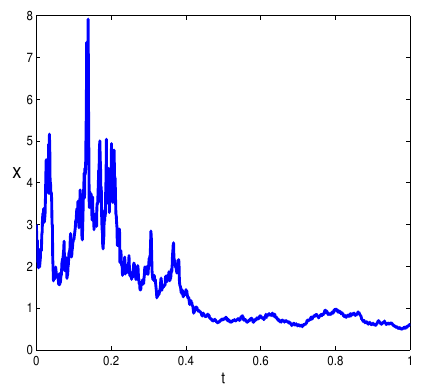
Figure 1. Dynamic responses for the first